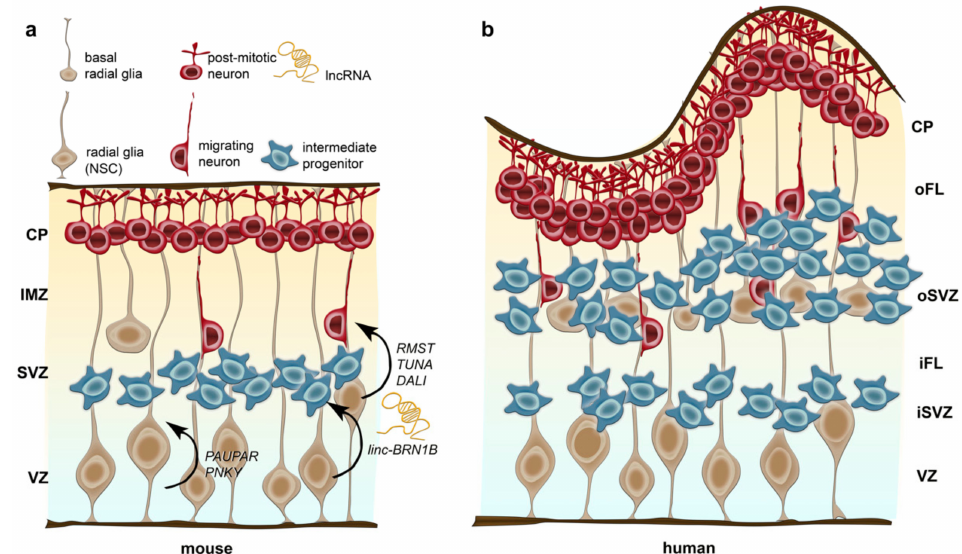
Figure 2. Schematic illustration of neurogenesis in the mouse ( a ) and human cerebral cortex ( b ) and, potential implications of discrete lncRNAs. Radial glia residing in the ventricular zone (VZ) are the neural stem cells (NSCs) in mice and humans, generating neurons, intermediate progenitors and basal radial glia cells. In contrast to intermediate progenitors, radial glia display a long basal process attached to the outer (basal) surface. The subventricular zone (SVZ), which hosts intermediate progenitors and basal radia glia, is dramatically expanded in humans and separated into an inner and outer SVZ (iSVZ and oSVZ, respectively) by the inner fibre layer (iFL). Post-mitotic neurons migrate along the basal processes of the radial glia out of the VZ and SVZ through the intermediate zone (IMZ) in rodents and the inner and outer fibre layer (iFL and oFL) in humans into the cortical plate (CP). In humans the cortex is highly folded in gyri and sulci, whereas the mouse brain is smooth. While Rmst , Tuna and Dali are suggested to drive neuronal di ff erentiation, Paupar and Pnky appear to be implicated in controlling the balance of self-renewal and neuronal di ff erentiation of neuronal progenitor cells. linc-Brn1b controls di ff erentiation of delaminating neural progenitor cells, presumably being involved in basal cortical progenitor turnover